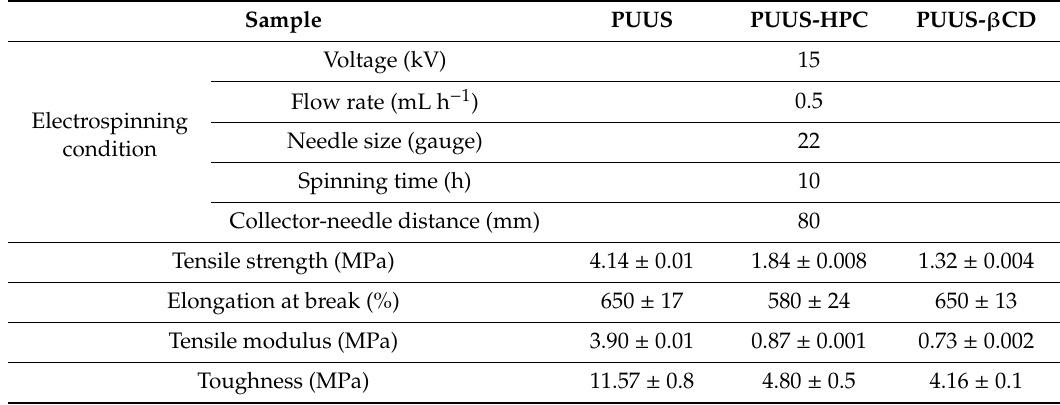
Figure 1. Schematic illustration of the experimental electrospinning procedure and preparation of polyurethane based nanofibrous composite mats. Table 1. Experimental electrospinning conditions and mechanical properties of polyurethane based nanofibrous composite mats.